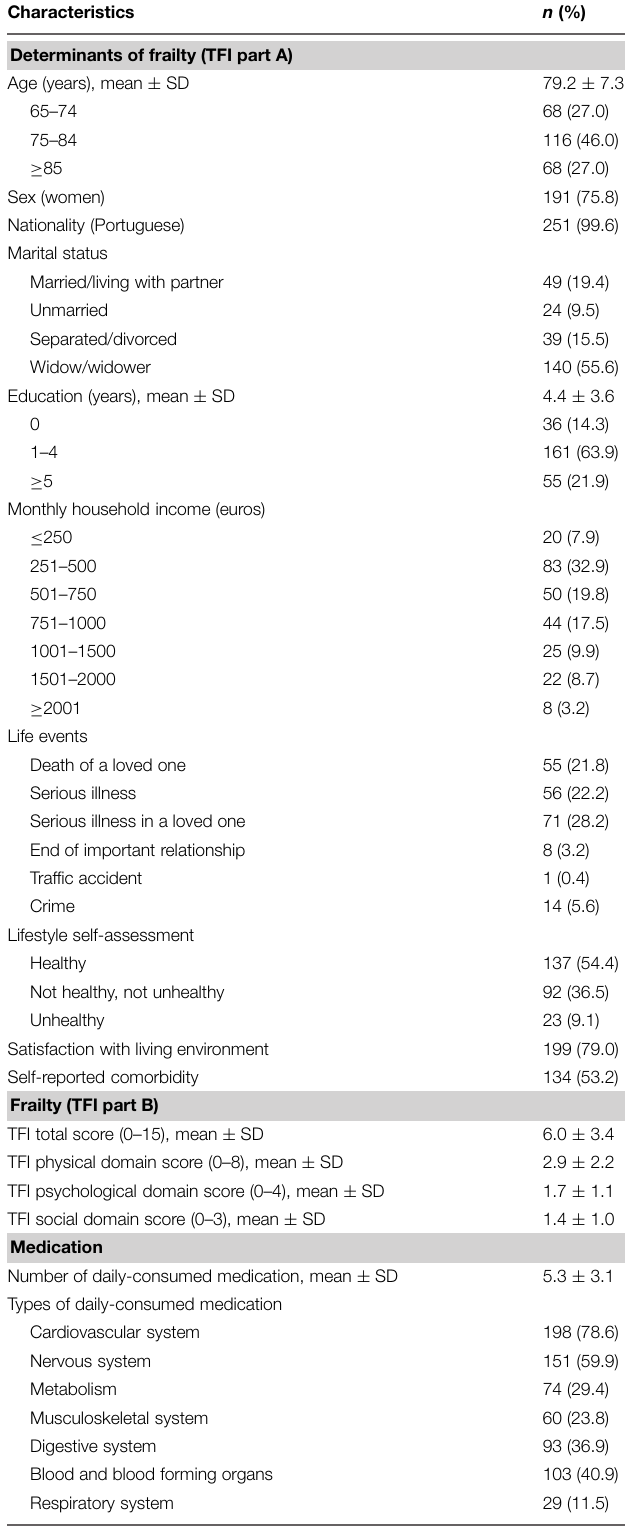
TABLE 1 | Characteristics of the participants ( n = 252) in regard to Determinants of frailty, frailty, medication.